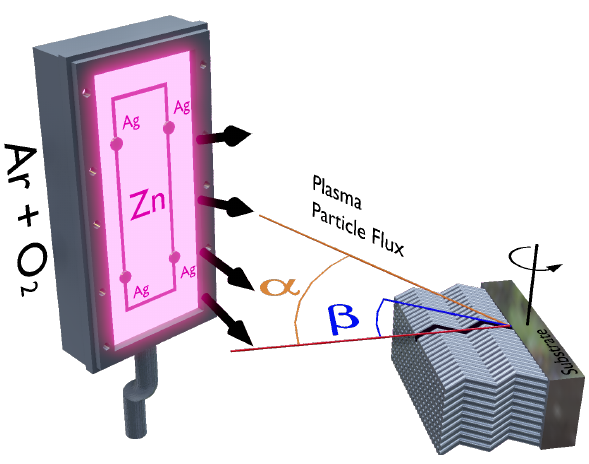
Figure 1. Schematic representation of the GLAD sputtering in which the α and β angles are indicated. The Zn target was decorated with a specific amount of Ag pellets (dark cylinders), symmetrically distributed along the main erosion area (50 cm 2 ) represented through the dark rectangle in the ZnO